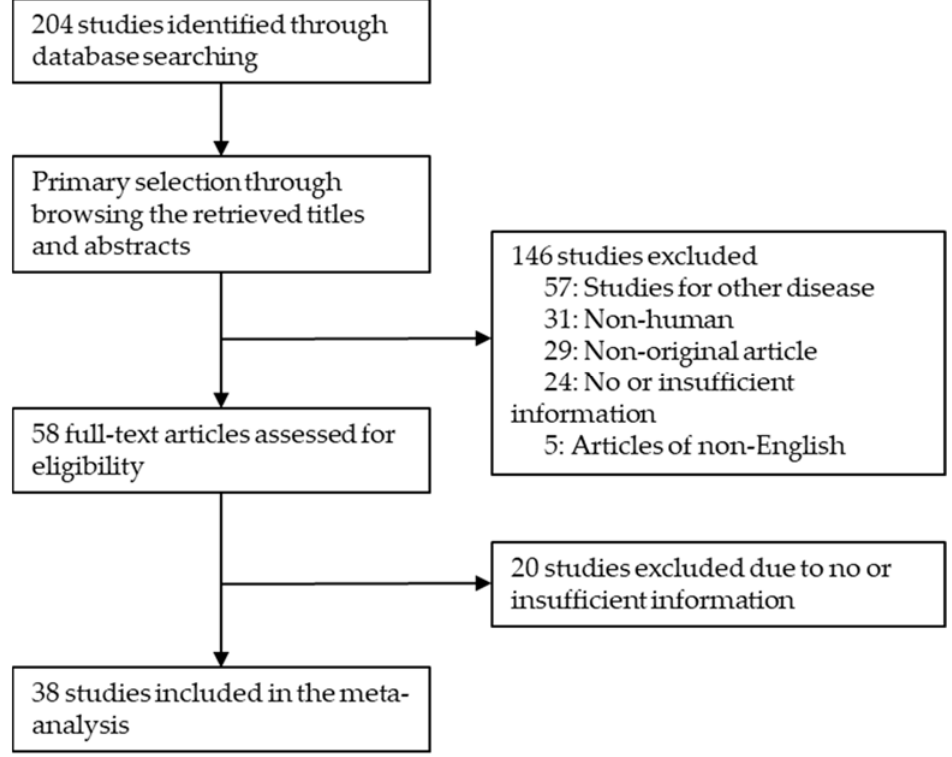
Figure 1. Flow chart of study search and selection methods.